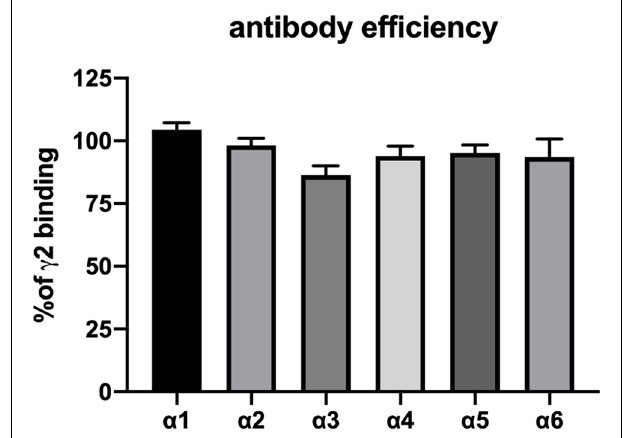
FIGURE 2 | Confirmation of the precipitation efficiency of subunit-specific antibodies used in this study. HEK 293 cells were transfected with the subunit combinations α 1 βγ 2, α 2 βγ 2, α 3 βγ 2, α 4 βγ 2, α 5 βγ 2, and α 6 βγ 2, lysed in deoxycholate (DOC) buffer and precipitated with 5 µ g antibody in 20 µ l phosphate-buffered saline as described in the “Materials and Methods” section. Precipitated pellets were subjected to radioligand binding assay with 2 nM 3 H-flunitrazepam ( α 1 βγ 2, α 2 βγ 2, α 3 βγ 2, and, α 5 βγ 2) or 5 nM 3 H-Ro 15-4513 ( α 4 βγ 2 and α 6 βγ 2). Nonspecific binding was analyzed by the addition of 5 µ M diazepam or 50 µ M Ro 15-1788. Results are expressed concerning values obtained with parallel precipitation with specific anti- γ 2 antibody. Shown are the mean ± SD of three independent experiments performed in duplicates each. None of the results shown differ statistically from 100% (as determined by a one-sample t and Wilcoxon test), indicating that all antibodies precipitate their target receptor with high